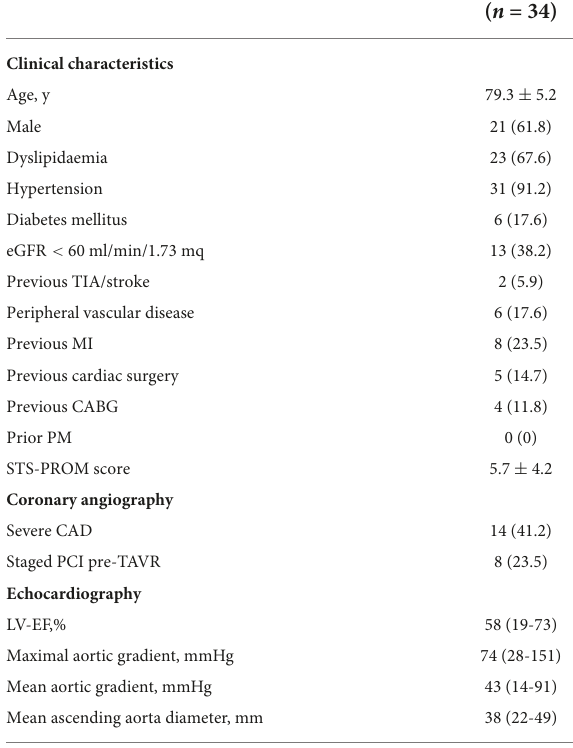
TABLE 1 Study population